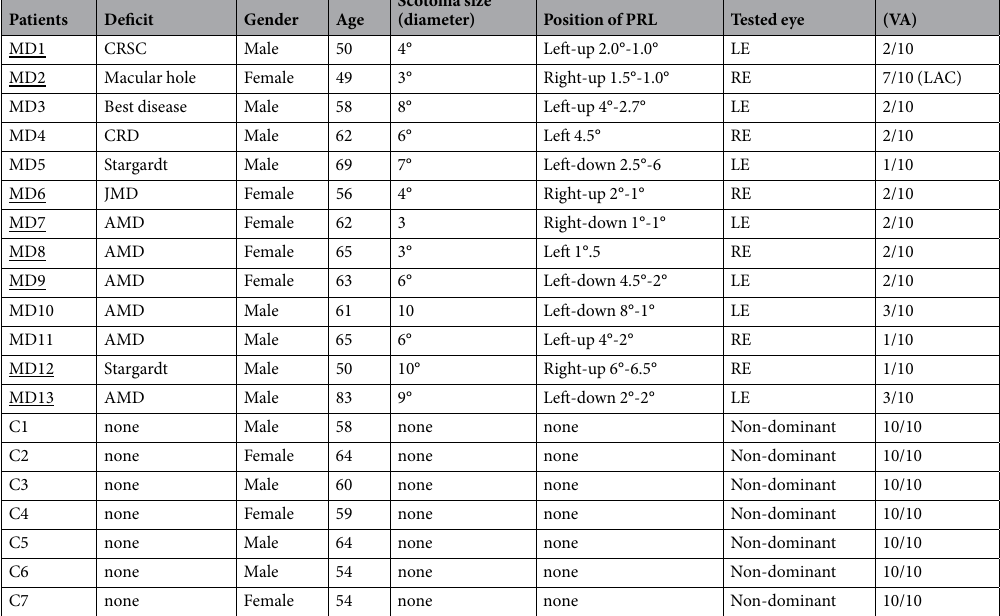
Table 1. Details of participants. The MD group consisted of six patients with AMD, one patient with juvenile macular degeneration (JMD), two patients with Stargardt disease, one with Best disease, one with a macular